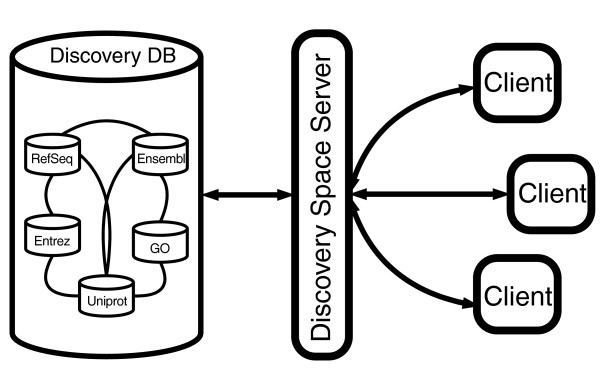
Diagram showing the three-tier architecture of DiscoverySpace. Many DiscoverySpace clients connect to the shared DiscoverySpace server using HTTP and DiscoverySpace's application-level protocol. Each DiscoverySpace server connects to a single database server using the database's JDBC (Java Database Connectivity) driver.